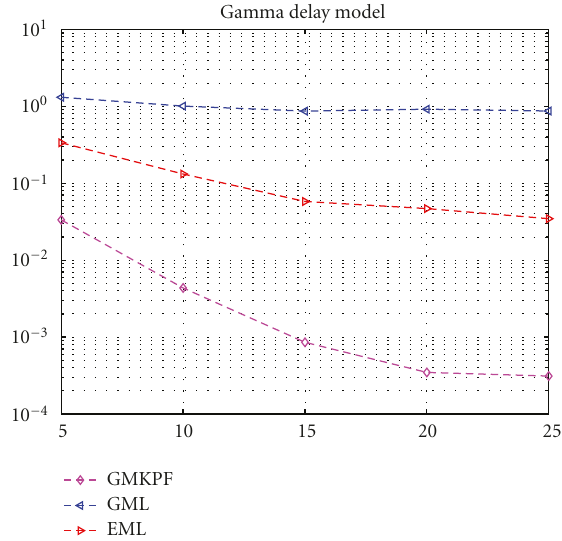
Figure 3: MSEs of clock o ff set estimators for Gamma random delays [ α 1 = 2, β 1 = 1].